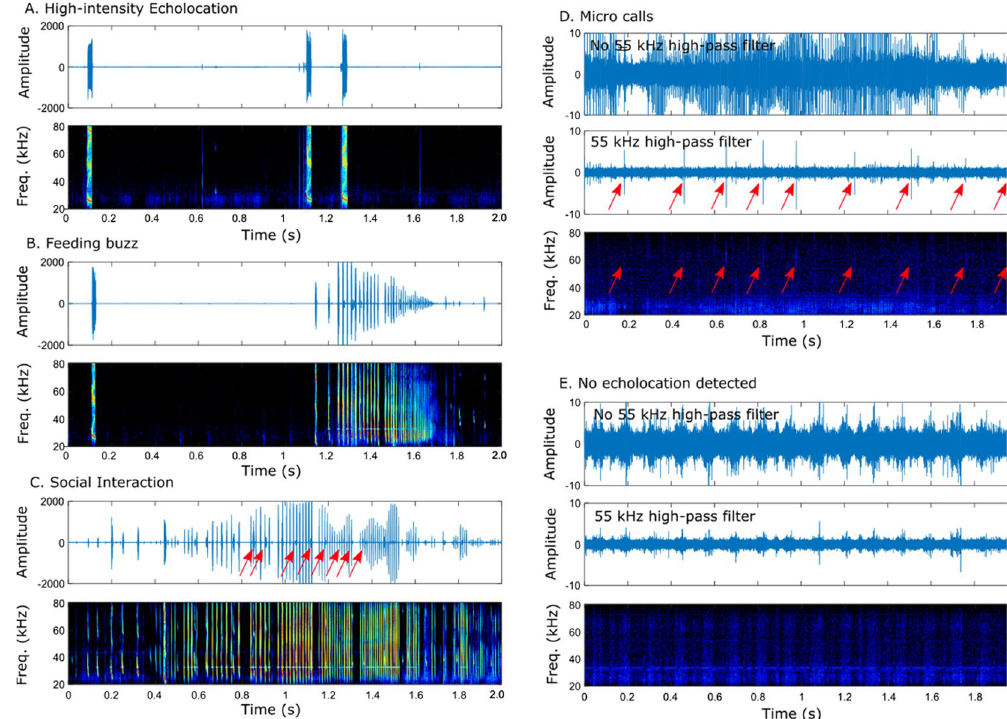
Figure 1. Example acoustic behaviors. Oscillograms (amplitude vs. time; top) and spectrograms (frequency vs time; bottom) are shown for clips of recordings to illustrate different acoustic behaviors. Two-second clips shown here were taken from longer 10-s recordings. A single oscillogram trace is shown for ( A – C ). Two oscillogram traces are shown for ( D , E ), one with and one without a 55-kHz high-pass filter, which removes low frequency wind noise and highlights the frequency range of micro calls. ( A ) High-intensity echolocation. A single echolocation pulse followed by an echolocation doublet. Note that these signals were overloaded on the microphone, resulting in spectrogram artefacts ( B ) Feeding buzz. A single echolocation call is followed by approximately 1-s pulse interval into a rapid feeding buzz. ( C ) Social interaction. Close inspection